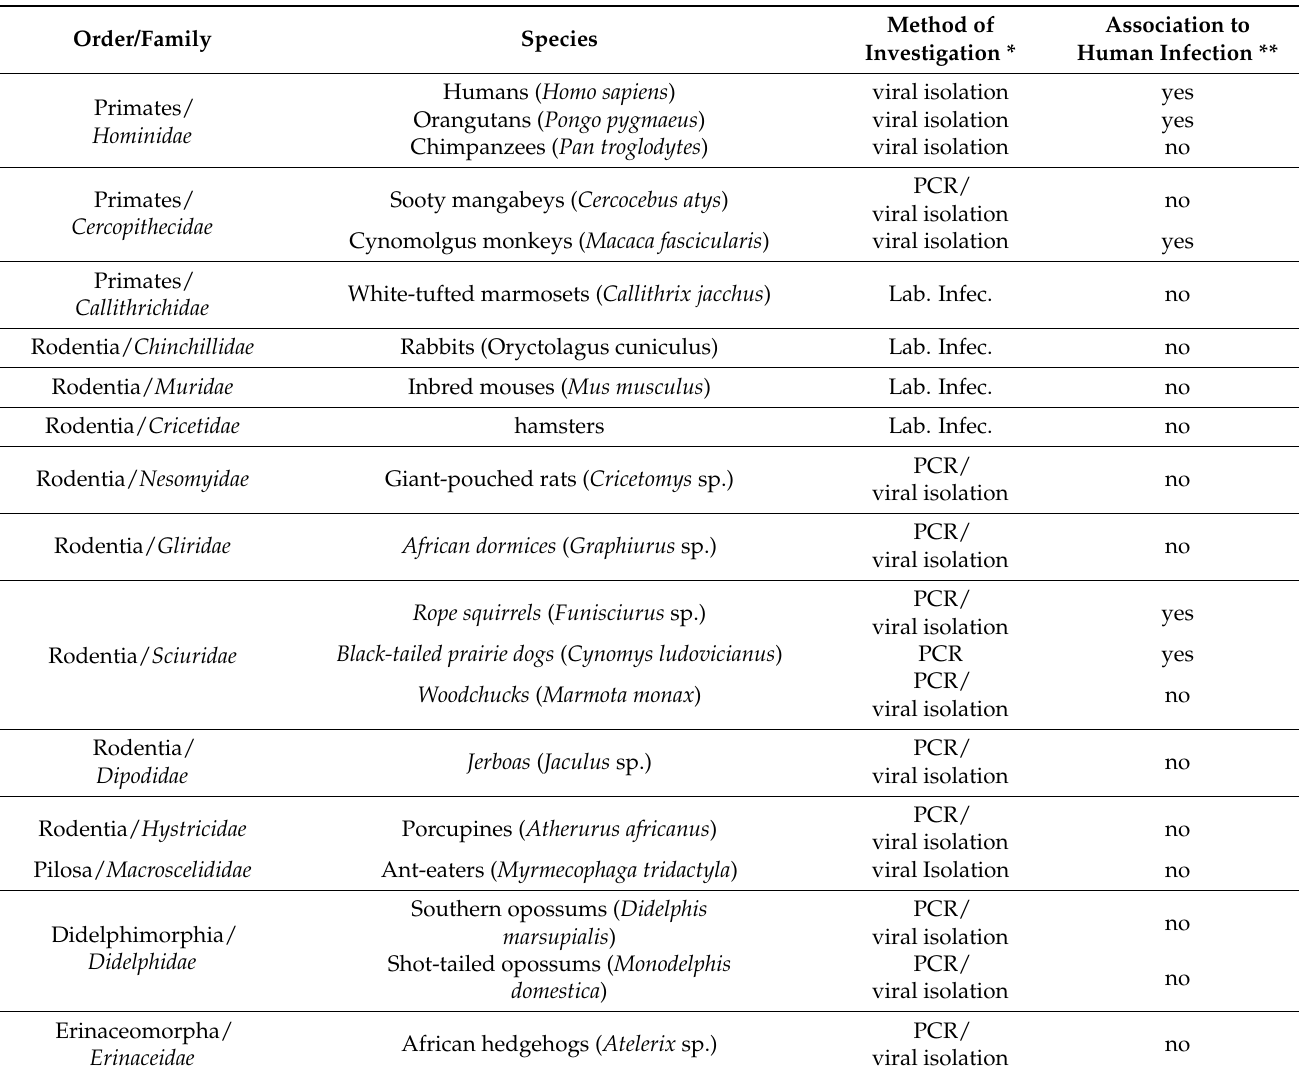
Table 1. Hosts and susceptible animals to monkeypox virus